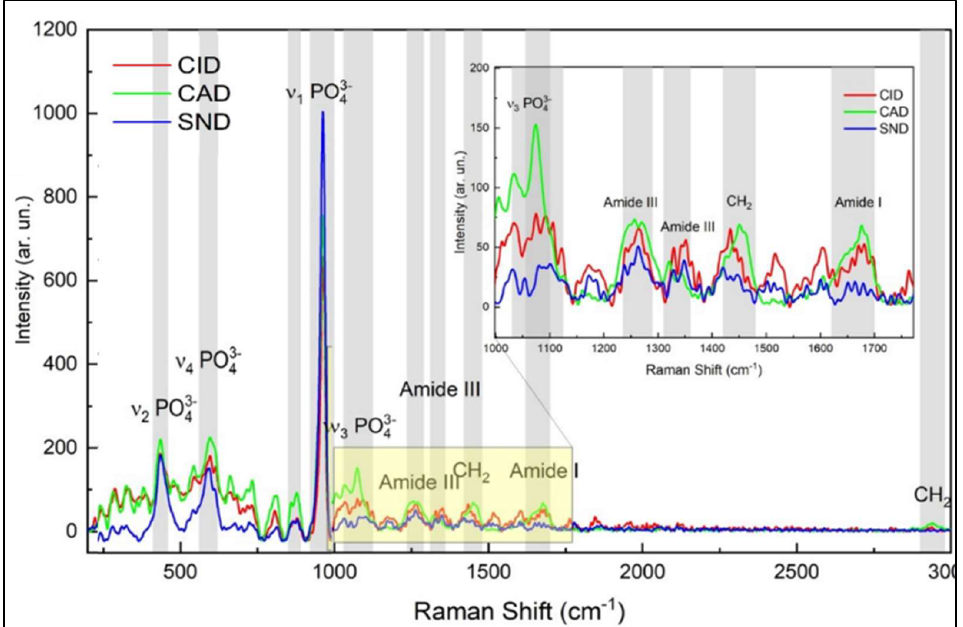
Figure 3. Representative Raman spectra of the caries-infected (CID), caries-affected (CAD) and sound dentin in the proximal carious lesion. The spectra were normalized based on the peak intensities of v1-PO at 960 cm −1 , which is the strongest signal among all Raman spectra, it is the highest in sound dentin. Amide I at 1650 cm −1 , Amide III at 1235 cm −1 and C-H bond of the pyrrolidine ring at 1450 cm −1 are higher in CID and CAD than sound dentin. The inserted figure shows the magnified, same spectra in the range from 1000 to 1700 cm −1 .